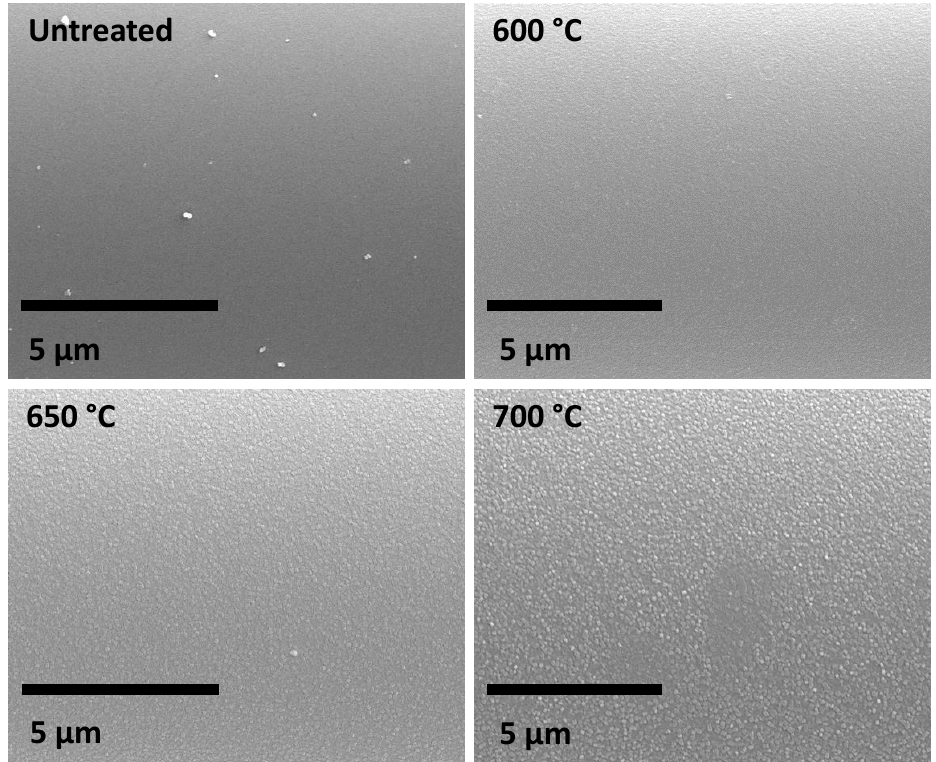
Figure 12. SEM images of E-glass fibre surfaces: untreated and following thermal conditioning at 600, 650 and 700 °C.